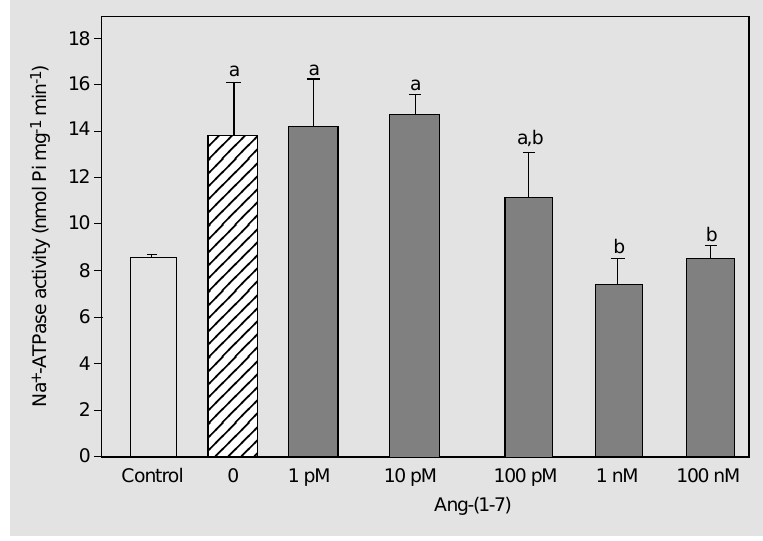
Figure 2. Role of Ang II in the modulation of Na + -ATPase activity by Ang-(1-7). Ang-(1-7) concentration was increased from 1 pM to 100 nM in the presence of 10 nM Ang II. ATPase activity was measured as described by Caruso-Neves et al. (9). Before assaying ATPase activity, the enzyme was preincubated for 20 min in the presence or in the absence of Ang II. The reaction was carried out in the presence of 10 nM Ang II. The data were analyzed as described in Figure 1. Results are reported as mean ± SEM. a P<0.05 compared to control (in the absence of Ang-(1-7) and Ang II) and b P<0.05 compared to the Na + -ATPase activity in the presence of Ang II (N =